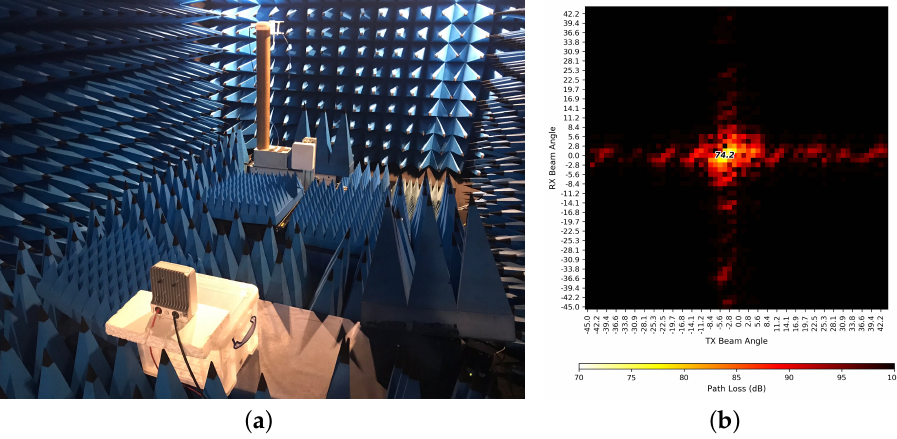
Figure 2. IEEE 802.11ad Terragraph platform validation in anechoic room, with a distance of 2 m between the antennas. ( a ) Measurement setup; ( b ) Angular path loss